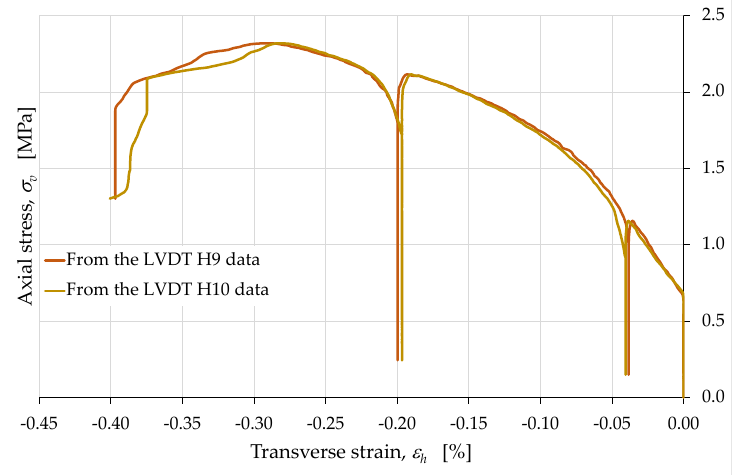
Figure 16. Axial stress/transverse strain curves acquired over the entire length of the long side faces.